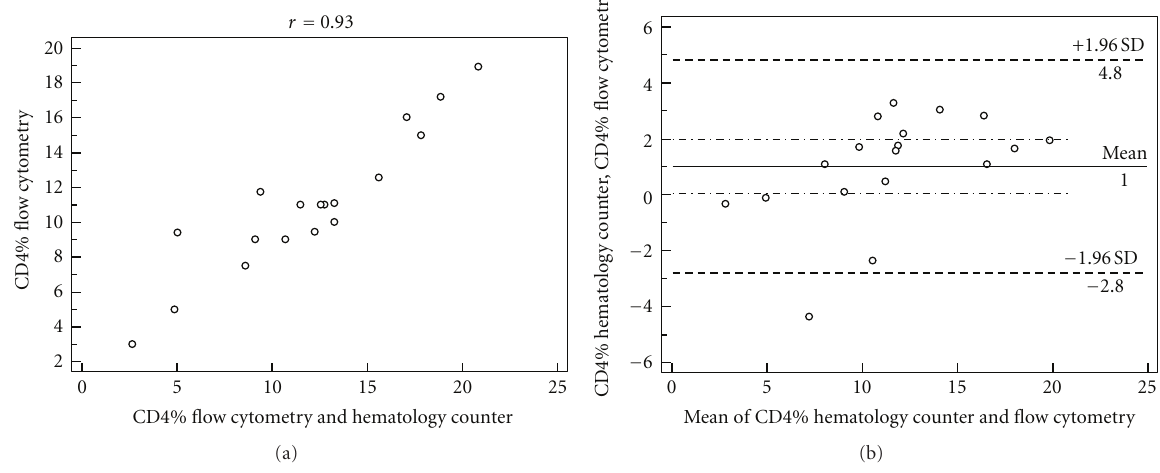
Figure 1: Correlation of percentage values of CD4+, P < 0 . 05 (a) and limits of agreement between the values estimated by Bland-Altman analysis (b) obtained by the hematology counter and the flow cytometer in the stratum of CD4 count < 200cells/mL.